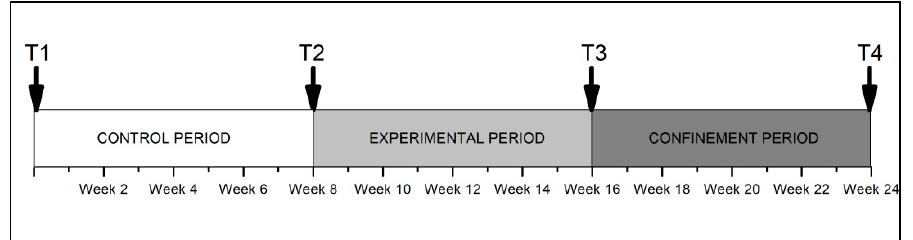
Figure 2. Study timeline. All participants were assessed four times: once as a baseline measure- ment upon entry to the programme (T1-Baseline), a second time after an eight-week control period (T2-Control), a third time after an eight-week adapted judo intervention (T3-Judo) and a fourth time after an eight-week lockdown period due to COVID-19